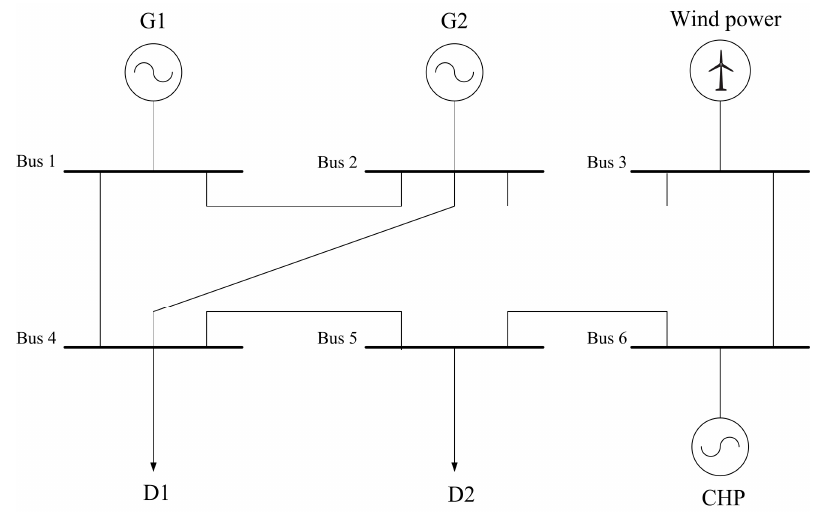
Figure 5. The six ‐ bus integrated CHP system. Figure 5. The six-bus integrated CHP system. Table 1. Components of the integrated CHP system scenarios. Table 1. Components of the integrated CHP system